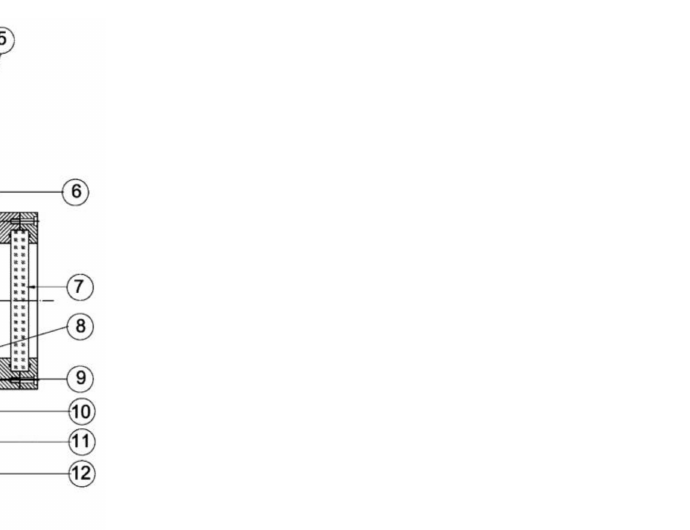
Figure 2. Section diagram of spray chamber. 1. Temperature sensor, 2. Pressure gauge, 3. Height adjusting device, 4. Inlet pipe, 5. Spray nozzle, 6. Spray chamber shell, 7. Observation window, 8. Thermocouples, 9. Heater block shell, 10. Copper heating block, 11. Alumina silicate fiber, 12. Heating block base plate.